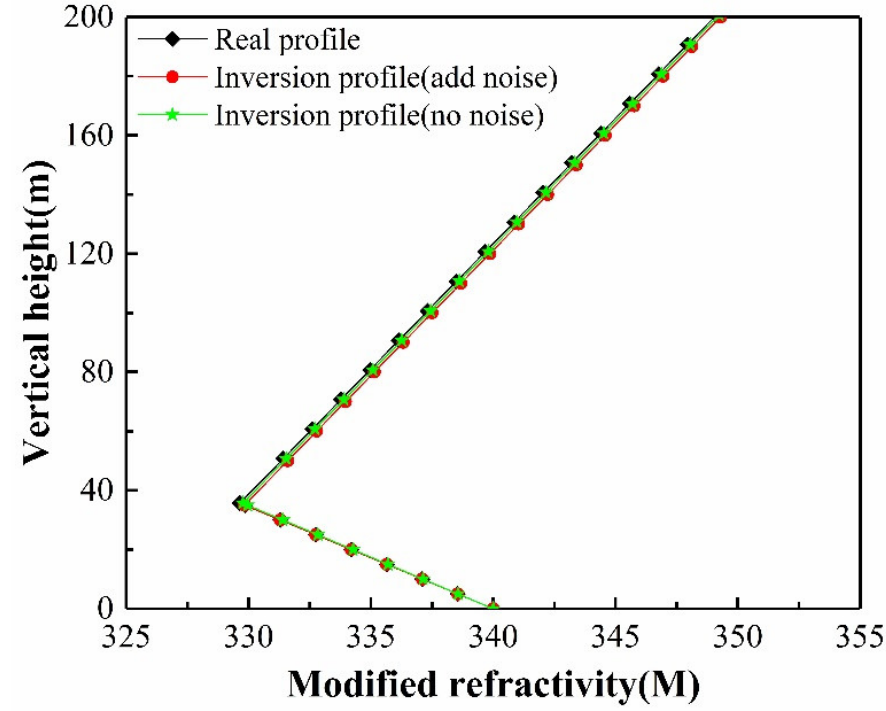
Figure 8. Evaporated duct refractive index profile inversion result.